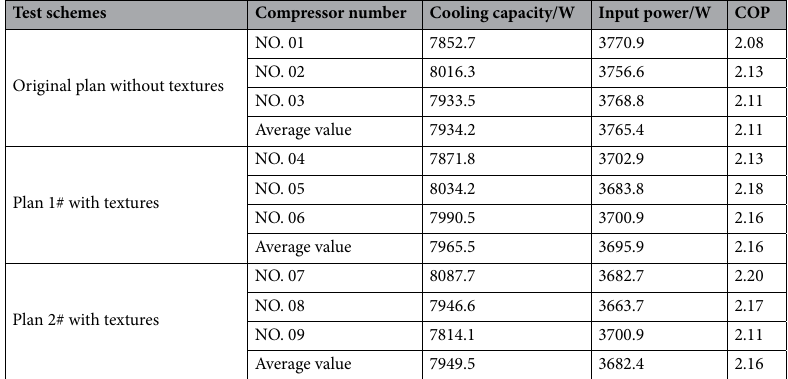
Table 4. Compressor performance test dada.